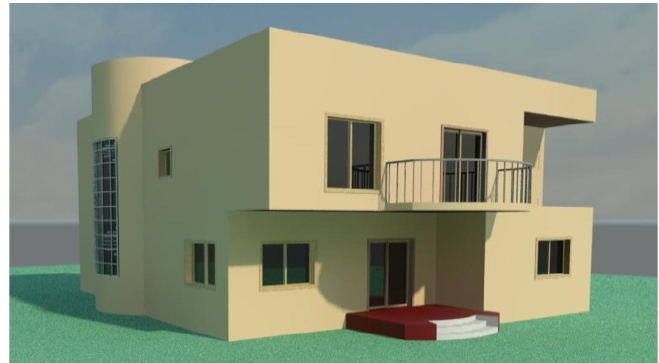
Figure 7. Isometric design of residential building: case study.